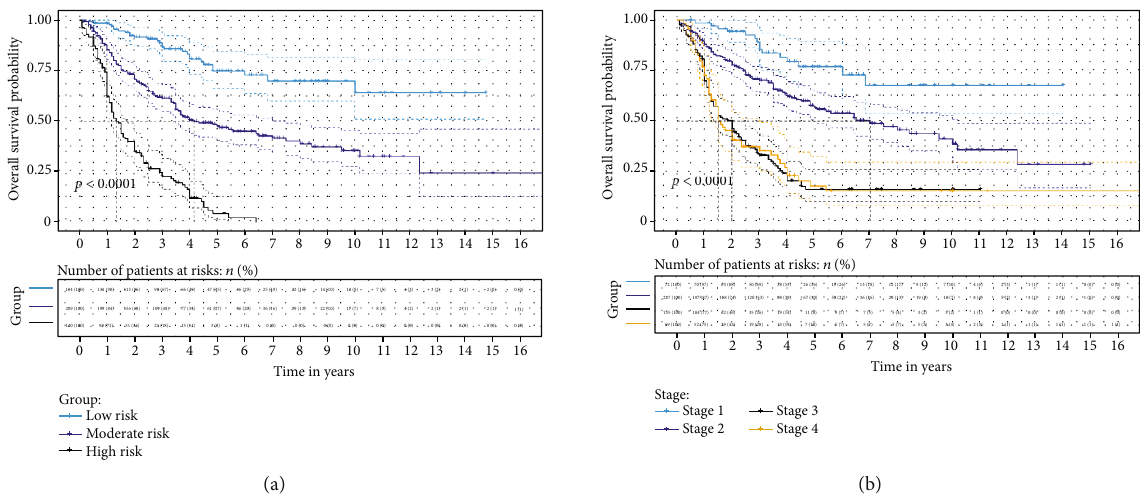
Figure 3: Kaplan-Meier survival curves of the primary cohort categorized by di ff erent staging systems for overall survival ((a) established model; (b) American Joint Committee on cancer (AJCC) seventh